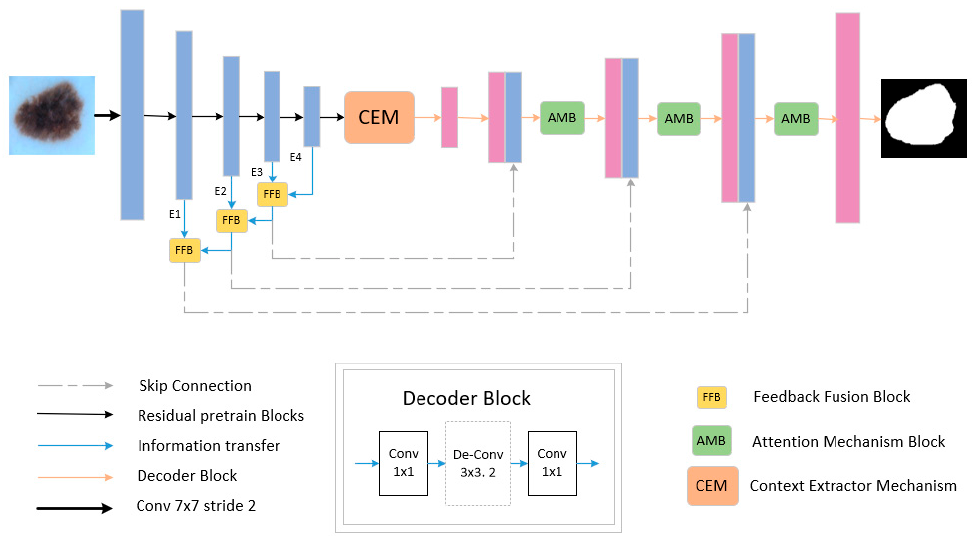
Figure 1. The overall design of FAC-Net. The dashed line indicates a skip connection. The yellow block represents the feedback fusion module, and the green block represents the attention module.